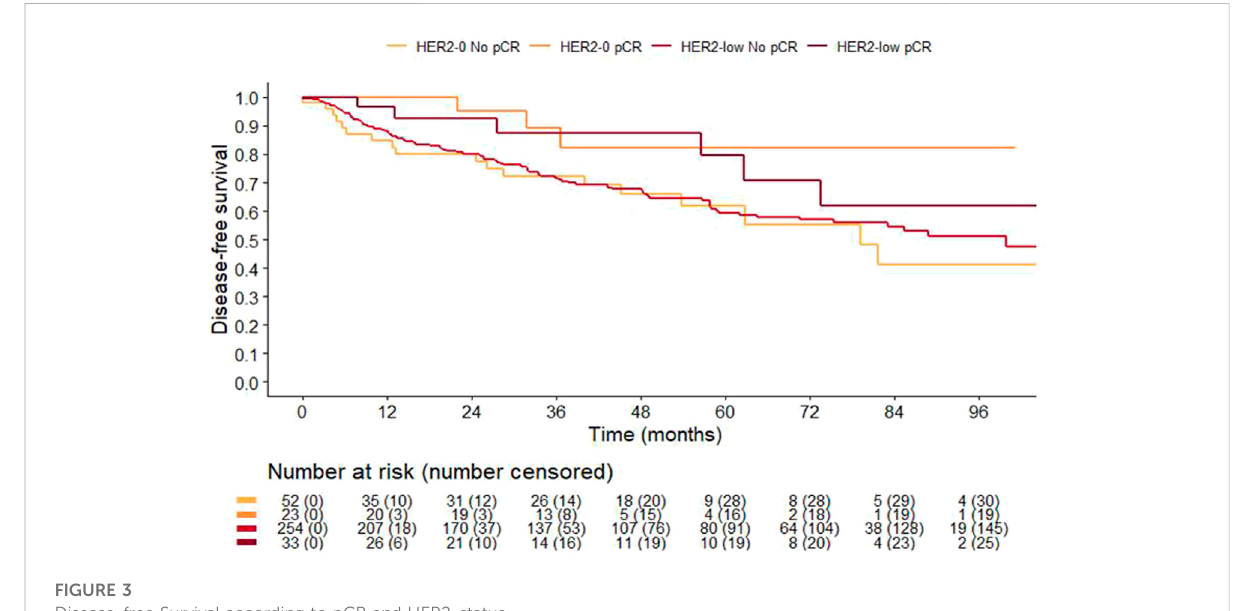
FIGURE 3 Disease-free Survival according to pCR and HER2-status.